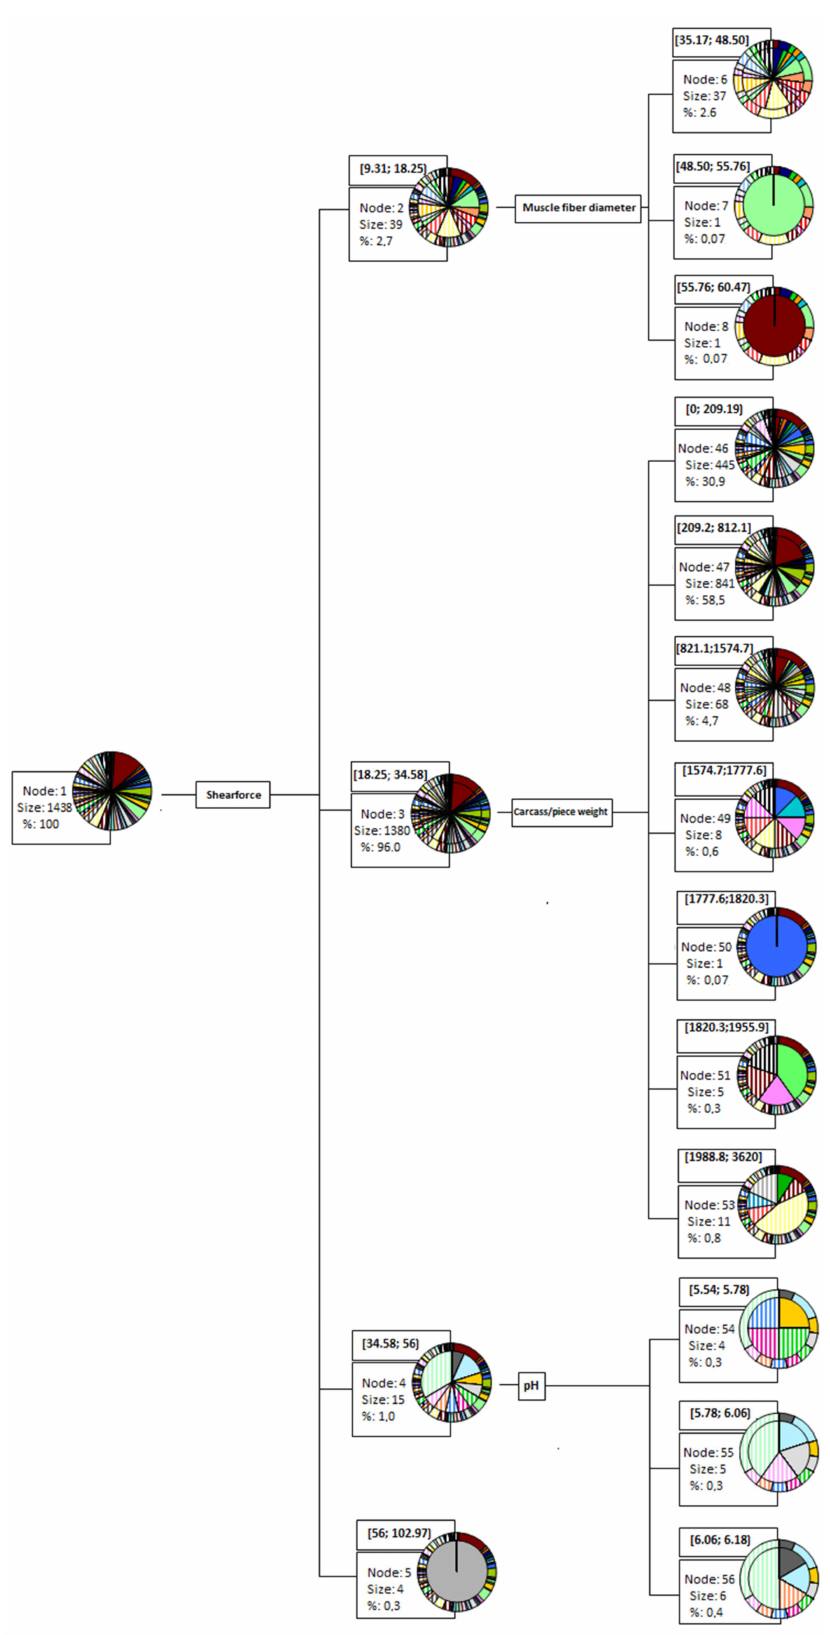
Figure 2. Graphic depiction of the most representative branches of the CHAID decision tree consider- ing native breed genotypes as the clustering